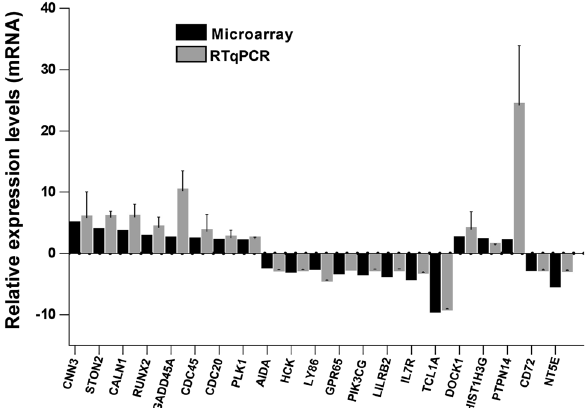
Fig. 3 Validation of microarray data by RTqPCR. Comparison of the expression levels of selected genes determined by microarray analysis and real time PCR. The relative expression was determined by the 2 −ΔΔCT method and the average of the values or peripheral blood (PB) sam- ples was used as a calibrator. The RT-qPCR data are expressed as the mean/SD of three independent analyses. Black bars represent microar- ray values and gray bars represent RT-qPCR